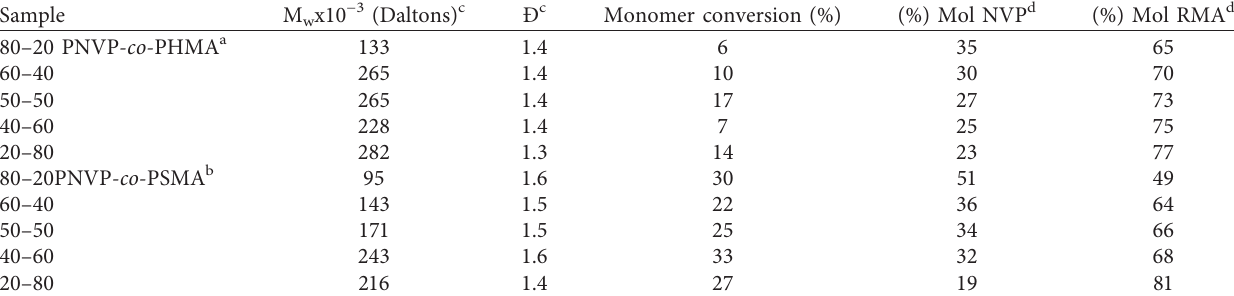
Table 1: Molecular characteristics of the PNVP-co-PRMA copolymers synthesized via RAFT. Sample